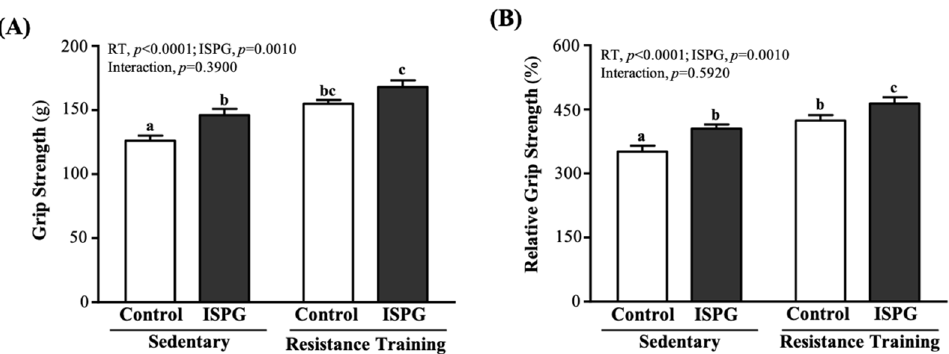
Figure 3. Effect of ISPG and resistance training on ( A ) absolute forelimb grip strength and ( B ) relative forelimb grip strength (%). All data are expressed as the mean ± SEM of 8 mice/group. Different superscript letters (a, b, c) above bars are significantly different at p < 0.05. If any letter is the same, it means that the difference between groups is not significant.